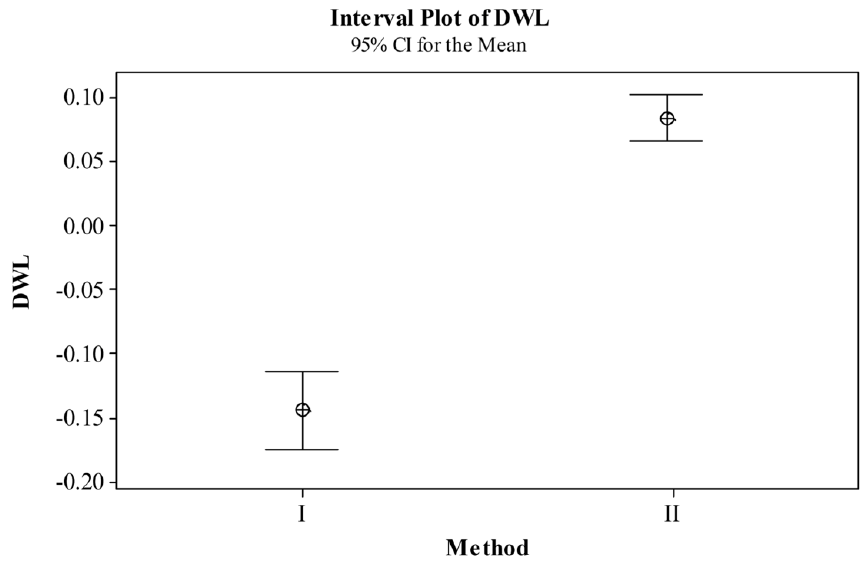
Figure 2. Interval plot of working length (WL) di ff erence values for the factor method.